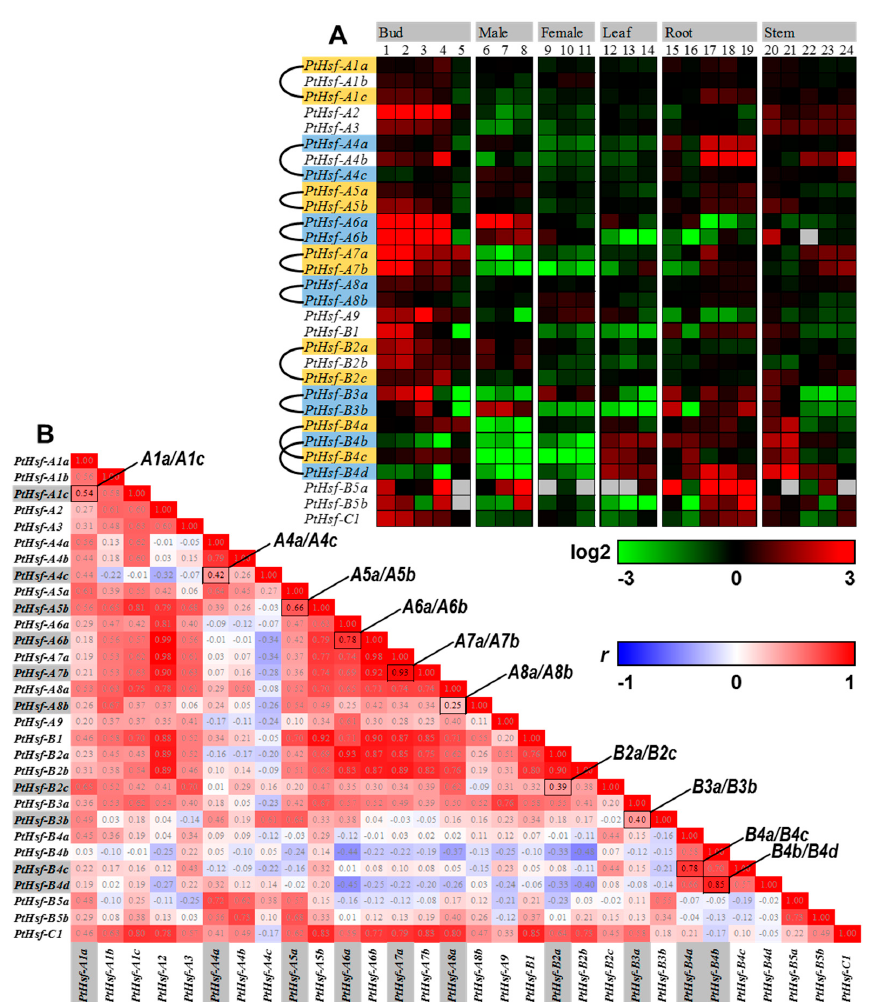
Figure 2. The expression patterns of PtHsf and the pairwise correlation co ‐ efficiency. ( A ) Expression patterns of PtHsfs across various tissues. (1) Pre ‐ dormant bud I, (2) Pre ‐ dormant bud II, (3)